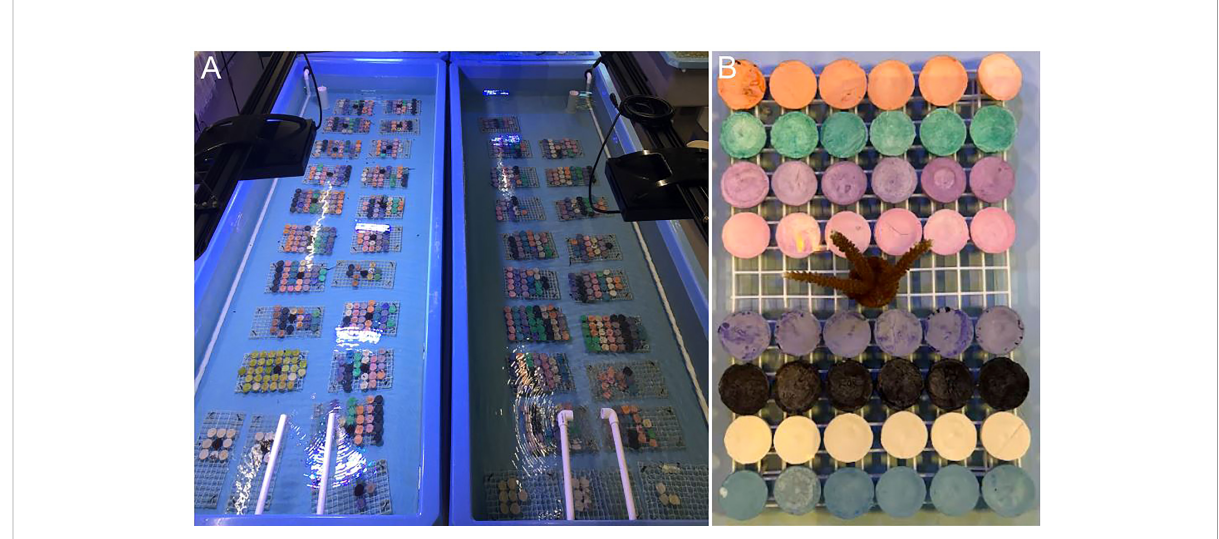
FIGURE 5 Optimizing grow-out of sexual recruits. (A) Crosses were equally divided into two treatments based on additional lighting (With treatment, left) or only ambient laboratory lighting (Without treatment, right). (B) Every rack of corals in the With treatment also received one adult coral to encourage faster uptake of algal symbionts. Source: Hanna